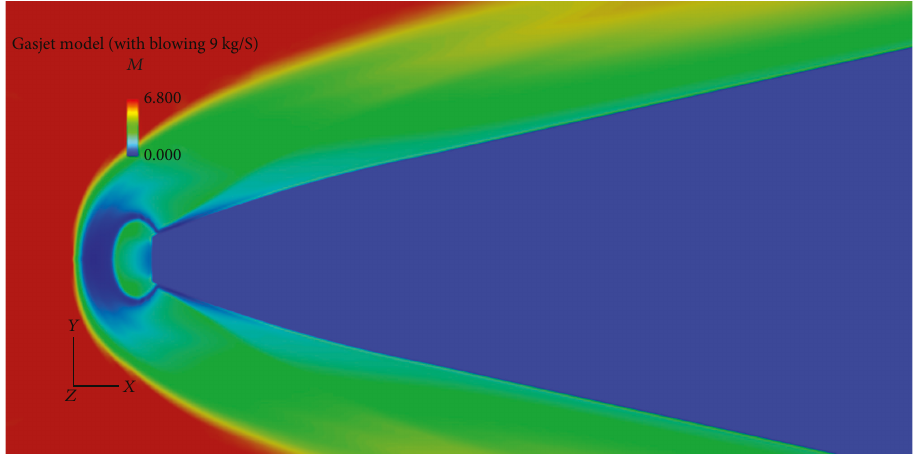
Figure 15: Gasjet model, blowing at fl at nose 0.91kg/S, Re = 4 3 × 10 6 , α = 0 0 ° , M = 6 8 .